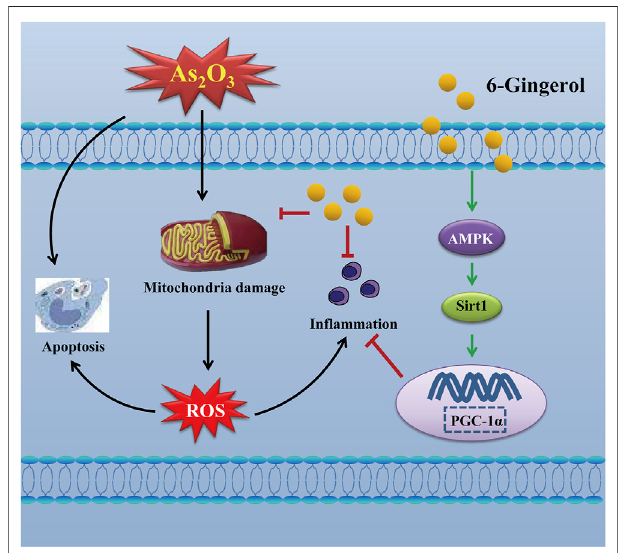
FIGURE 11 | Mechanism of 6G on As 2 O 3 -induced